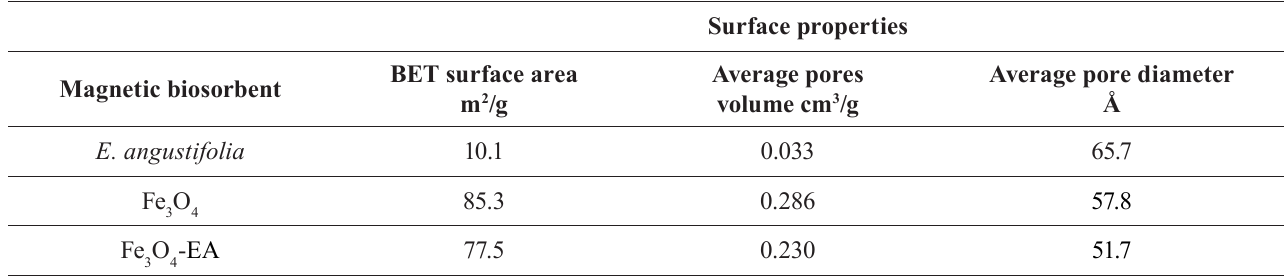
O and Fe O 3 4 3 4